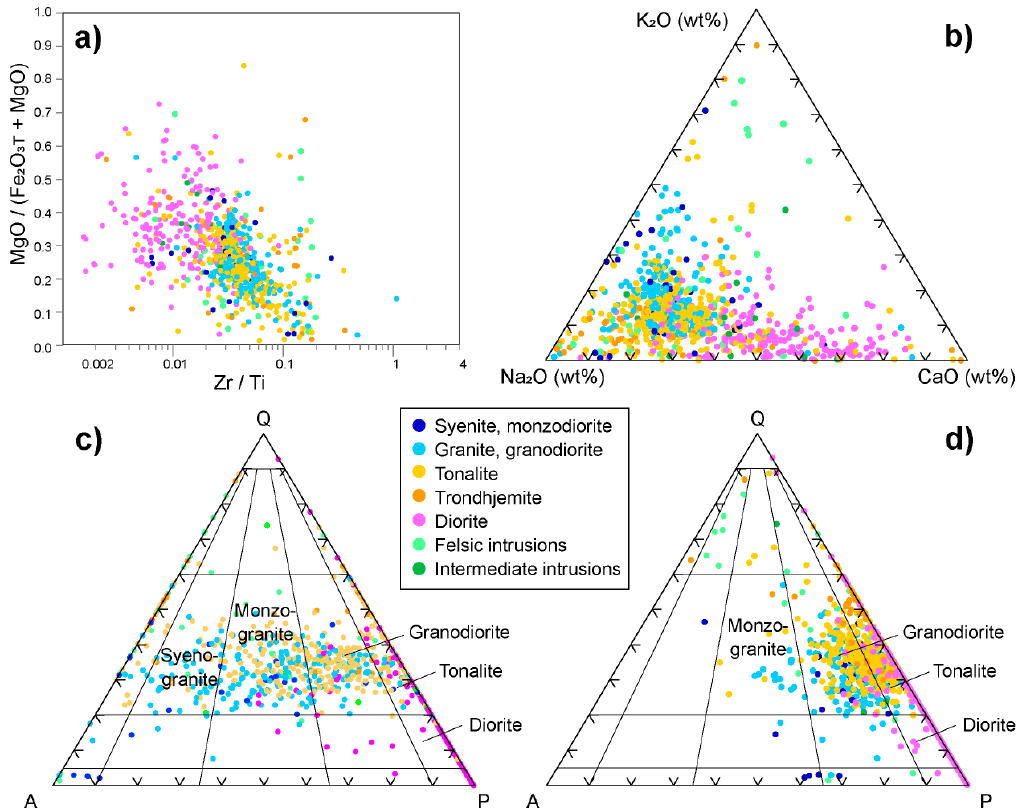
Figure 4. Chemical composition of intermediate-felsic intrusive rocks of the Sigeom dataset ( n = 840) displayed in plots of ( a ) Mg number vs. Zr/Ti binary, ( b ) Na 2 O-K 2 O-CaO (in wt%) ternary, and ( c,d )